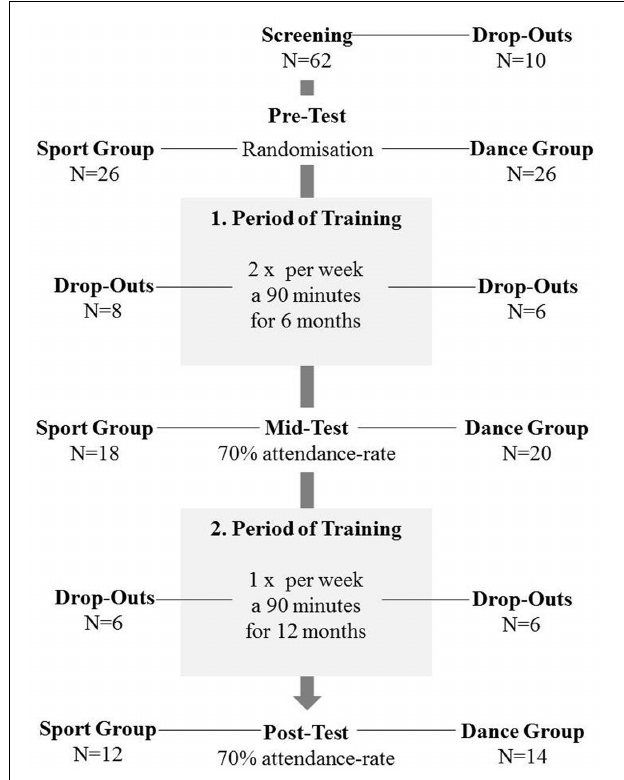
FIGURE 1 | Study design presenting: voluntary recruitment, drop-outs, time-points of measurement, duration of training periods.